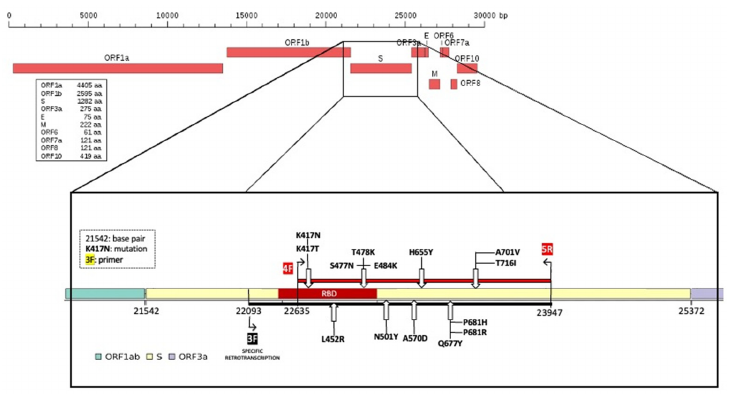
Figure 2. Some of the SNVs located along the spike gene detectable with the presented workflow. Black line, retro-transcribed region with specific primer (3F) and red line, amplified and sequenced “hot spot mutation fragment”.